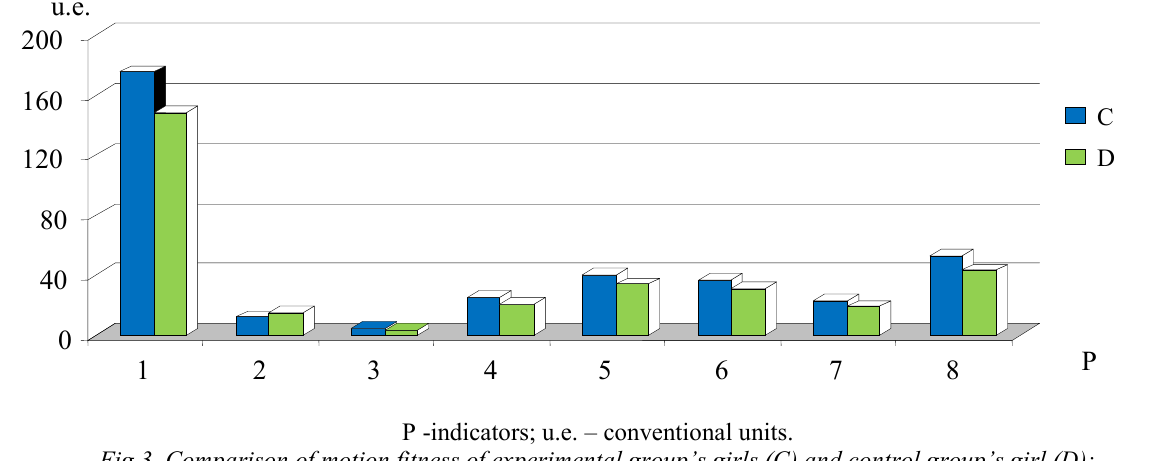
Fig.3. Comparison of motion fitness of experimental group’s girls (C) and control group’s girl (D): 1 – shuttle run; 2 – forward torso bending; 3 – taking sitting position from lying one during 1 minute; 4 – backbone dynamometry (torso); 5 – long jump; 6 – chin ups; 7 – hanging on bent arms; 8 – pressing ups in lying